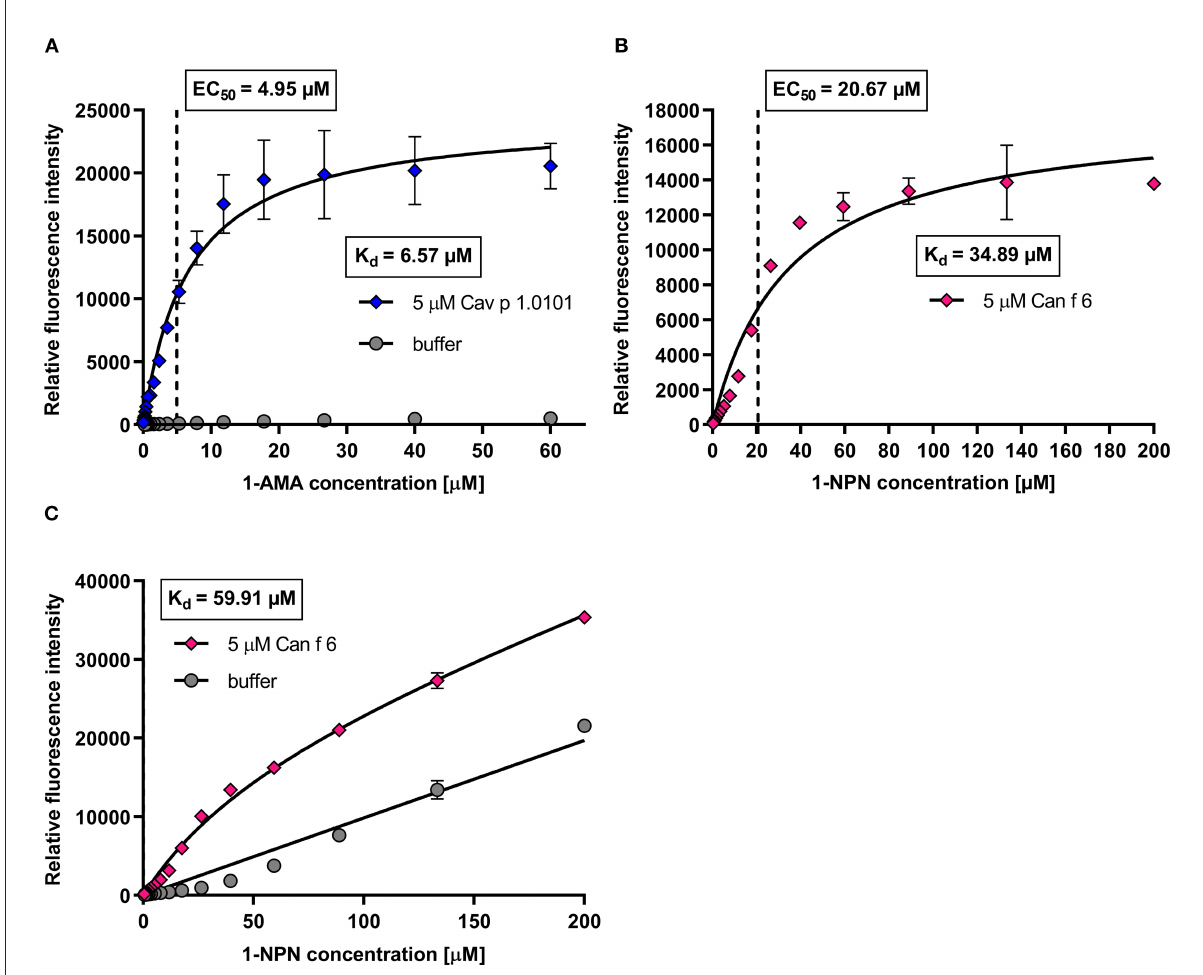
FIGURE5 Example of dose-dependent fluorochrome titration curves with guinea pig lipocalin Cav p 1 and dog lipocalin Can f 6. (A) Mean fluorescence intensity ( λ ex = 380nm; λ em = 485nm) of 5 µ M Cav p 1.0101 titrated with 1-AMA (0–60 µ M) in a 1.5 dilution series. Equilibrium dissociation constants (K d ) and EC 50 values were calculated by non-linear regression using a one-site fit specific binding model. Total and non-specific binding are depicted. (B,C) Mean fluorescence intensity ( λ ex = 337nm; λ em = 395nm) of 5 µ M Can f 6 titrated with 1-NPN (0–200 µ M) in a 1.5 dilution series. K d and EC 50 values were calculated by one-site fit models of specific binding (B) and of total and non-specific binding (C)